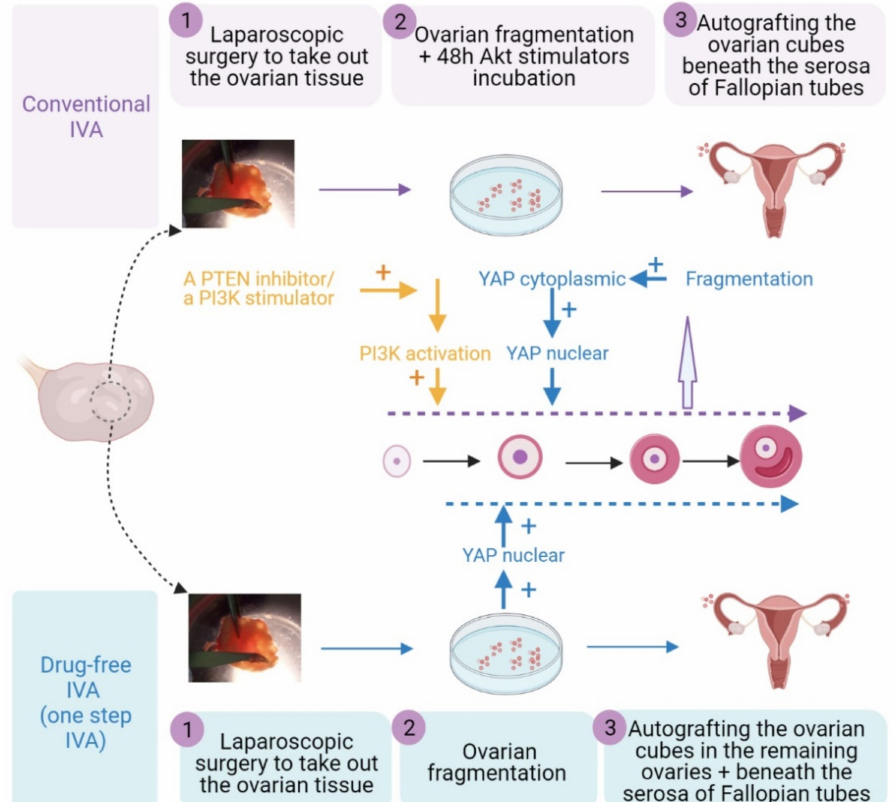
Figure 4. Comparison of the clinical approach between conventional IVA and drug-free IVA. In conventional IVA, one or both ovaries from POI patients were removed under laparoscopic surgery and cut into strips before vitrification. After thawing, strips were fragmented into 1–2 mm cubes, before incubation with Akt stimulators. Two days later, cultured cubes were autografted under second laparoscopic surgery beneath the serosa of Fallopian tubes. In drug-free IVA, the ovarian cortical tissues were removed and fragmented into 1–2 mm cubes followed by grafting back without culture in remaining ovaries and beneath the serosa of Fallopian tubes within the same